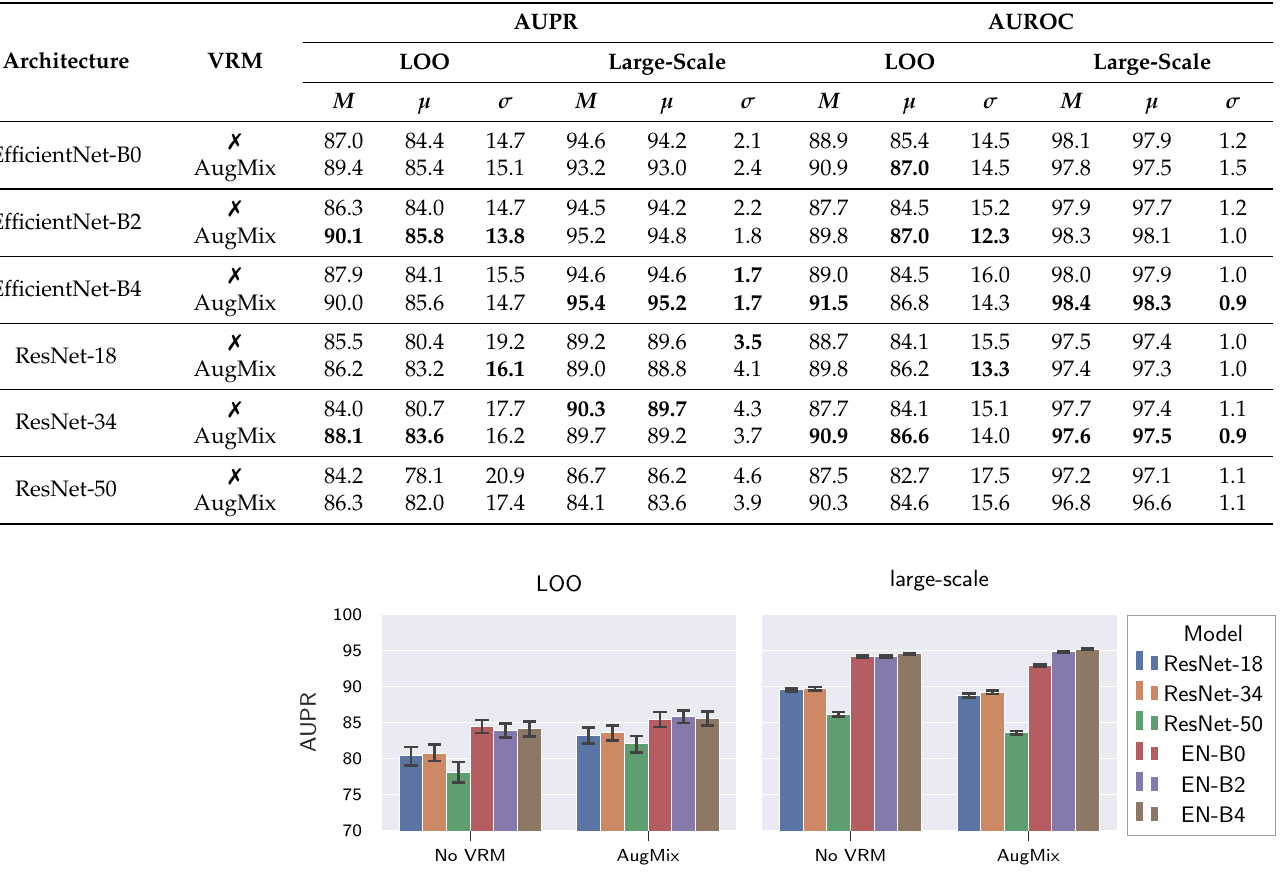
Table 7. Influence of model architecture and complexity as well as AugMix on the generalization of supervised fabric AD methods. Scores on the held-out fabrics and on the test set of the large-scale dataset used for model training are reported for pre-trained models fine-tuned with HSC loss and with or without application of AugMix. Dataset B is used for training, and best scores within each model architecture are highlighted in bold.